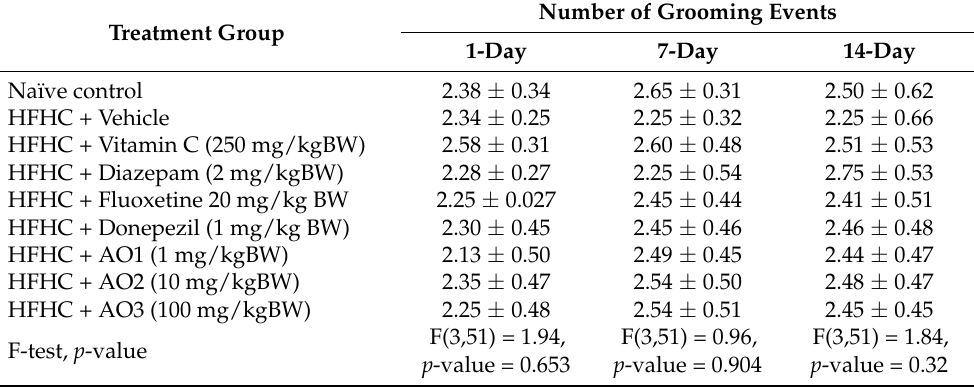
Table 4. Effect of the functional ingredient containing cashew leaf extract and cashew apple pomace- derived dietary fiber (AO) on number of grooming events. Data are presented as mean ± SEM) n =